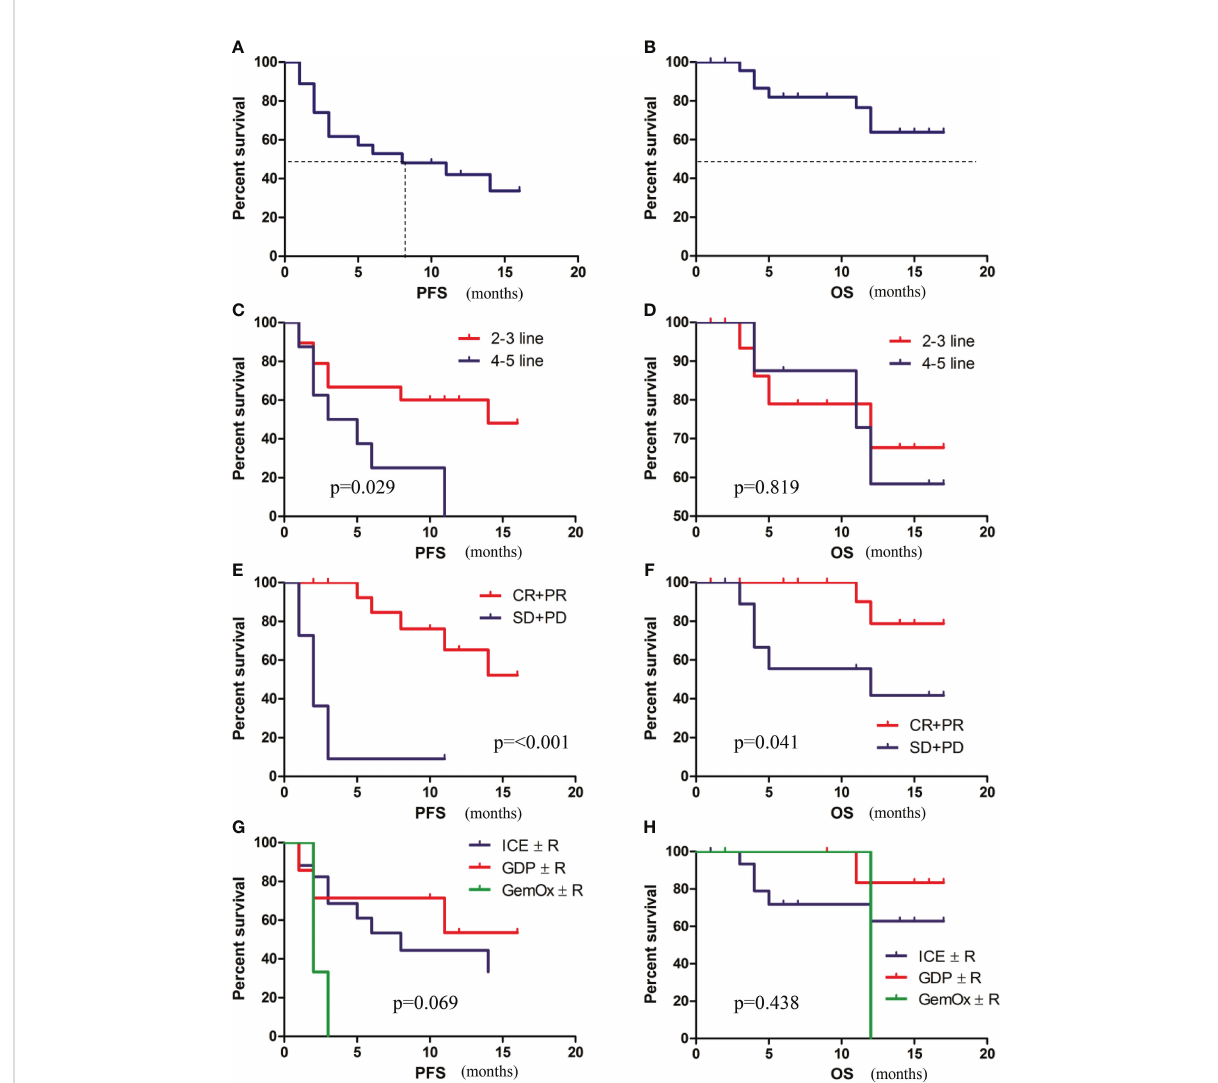
FIGURE 3 Survival analysis of patients. (A) PFS of patients. (B) OS of patients. (C) PFS of patients with early treatment (2-3 lines) versus late treatment (4-5 lines). (D) OS of patients with early treatment (2-3 lines) versus late treatment (4-5 lines). (E) PFS of patients with or without an overall response. (F) OS of patients with or without an overall response. (G) PFS according to combination regimens. (H) OS according to combination